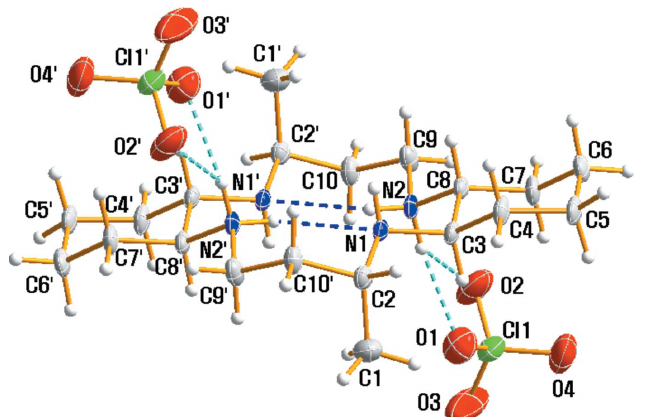
Figure 1 The molecular structure of compound (I), drawn with displacement ellipsoids at the 50% probability level. Dashed lines represent hydrogen- bonding interactions and primed atoms are related by the symmetry operation ( (cid:3) x + 1, (cid:3) y + 2, (cid:3) z +